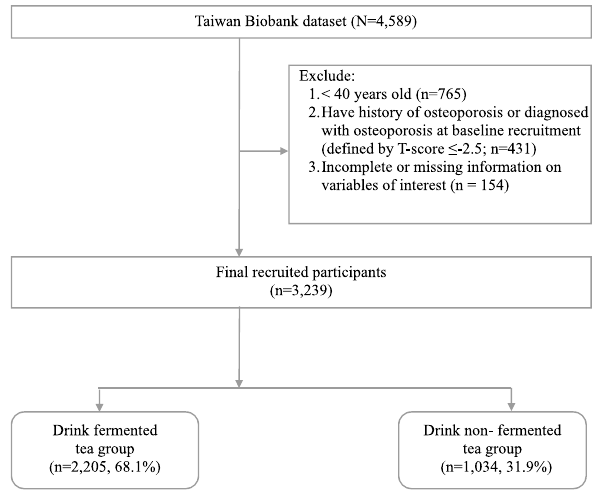
Figure 1. A flowchart demonstrating the enrollment of the study cohort. A total of 3239 participants had tea drinking habits, among whom 2205 (68.1%) participants had a fermented tea drinking habits and 1034 (31.9%) participants had non-fermented tea drinking